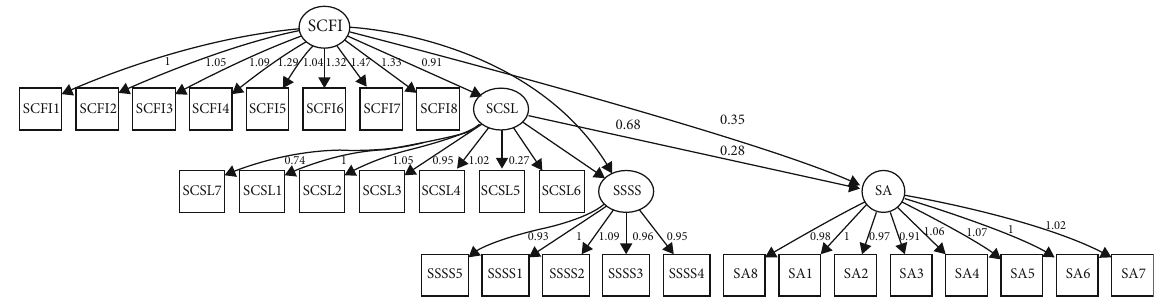
Figure 2: Maximum likelihood estimates for research model. Table 6: Fit indices for maximum likelihood SEM.